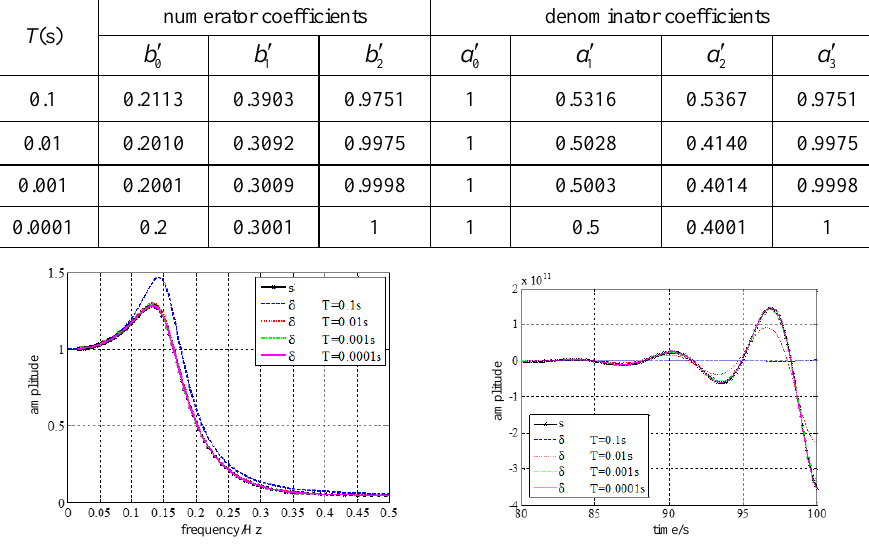
Fig. 3. Amplitude-frequency curves of δ -domain. Fig. 4. Step response curves of δ -domain.